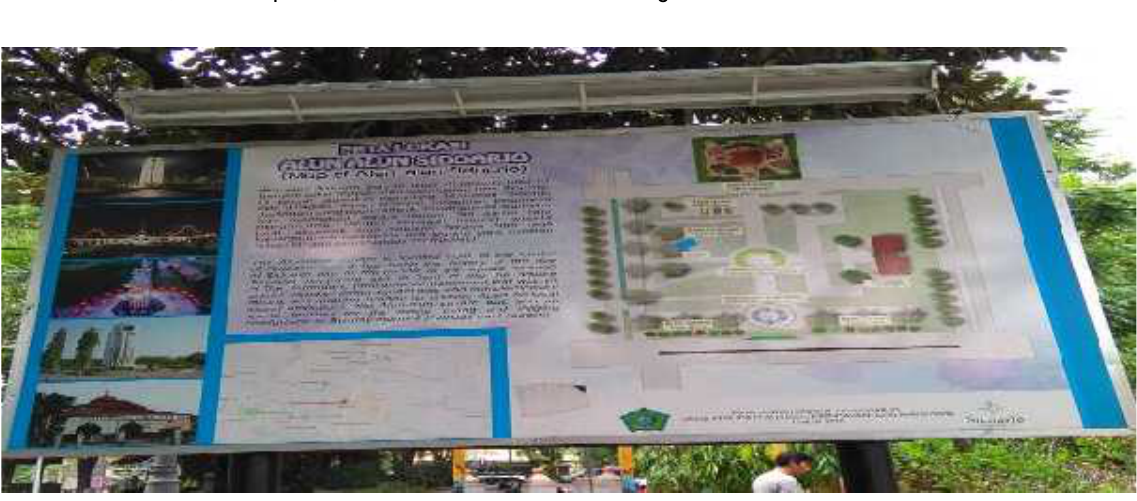
Figure 10. Map of Town Square